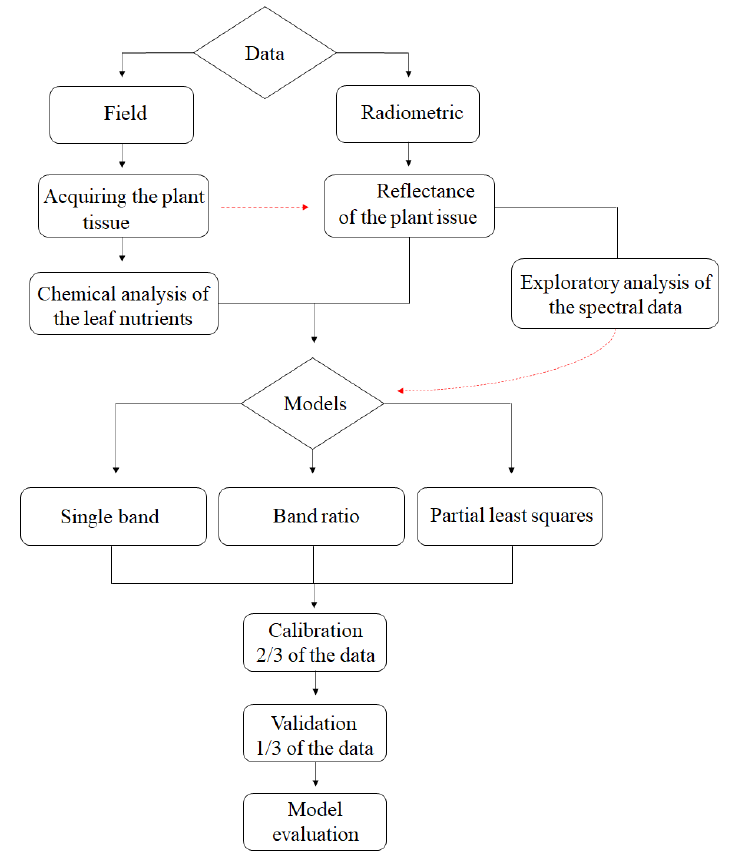
Figure 2. Flowchart of the methodology adopted in the study. The crop cycle of Vigna unguiculata (L.) Walp is composed of ten phenological stages, five vegetative and five reproductive stages. The vegetative stages are: Start of germina- tion (V0); Cotyledons level with the soil (V1); Expanded primary leaves (V2); First trifoli- ate leaf (V3); and Third trifoliate leaf (V4), respectively. The reproductive stages are: Flower bud formation (R5); Opening of the first flower (R6); Appearance of pods (R7); First full pods (R8) and Physiological maturity (R9), respectively, defined by Dourado Neto and Fancelli [39]. The leaf samples were collected at stages V4 (third fully open com- posite leaf), R6 (at least 50% of open flowers) and R9 (pod maturation). According to Em- brapa [34], the most critical stages of Vigna unguiculata (L.) Walp correspond to the stage